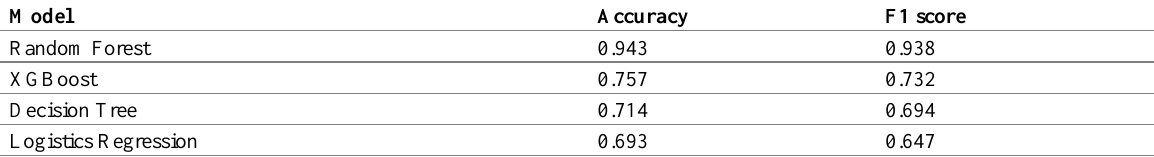
Table 3: Performance Measures Between Ml and Logit